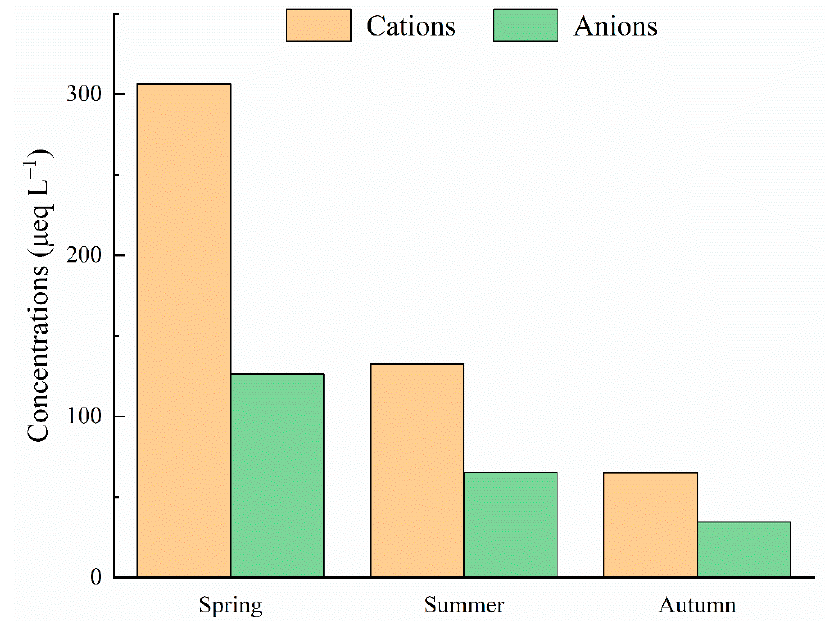
Figure 4. Comparison of VWM cations and anions concentrations in different seasons.